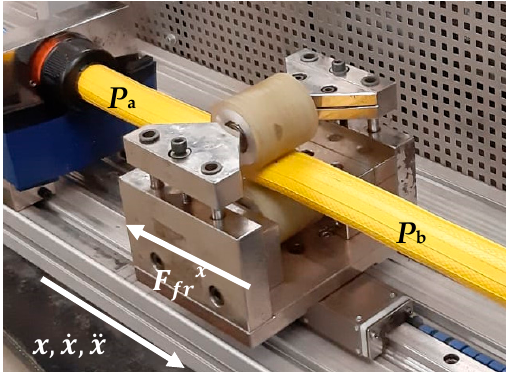
Figure 2. Mechanical model nomenclature.